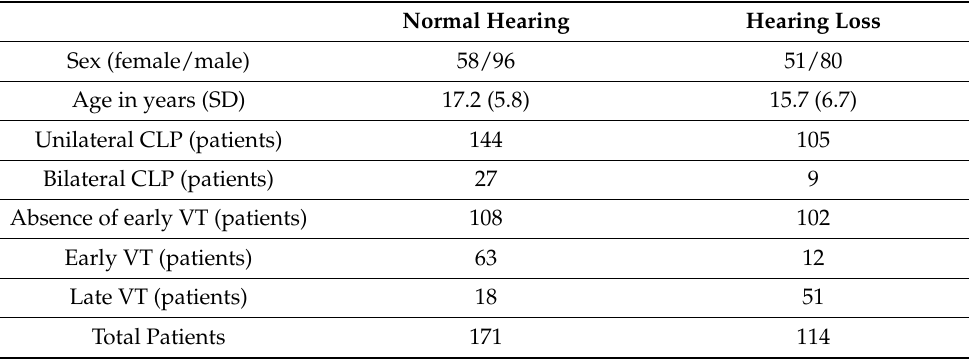
Table 1. Demographic and clinical characteristics of cleft lip and palate (CLP) patients according to hearing status at last available